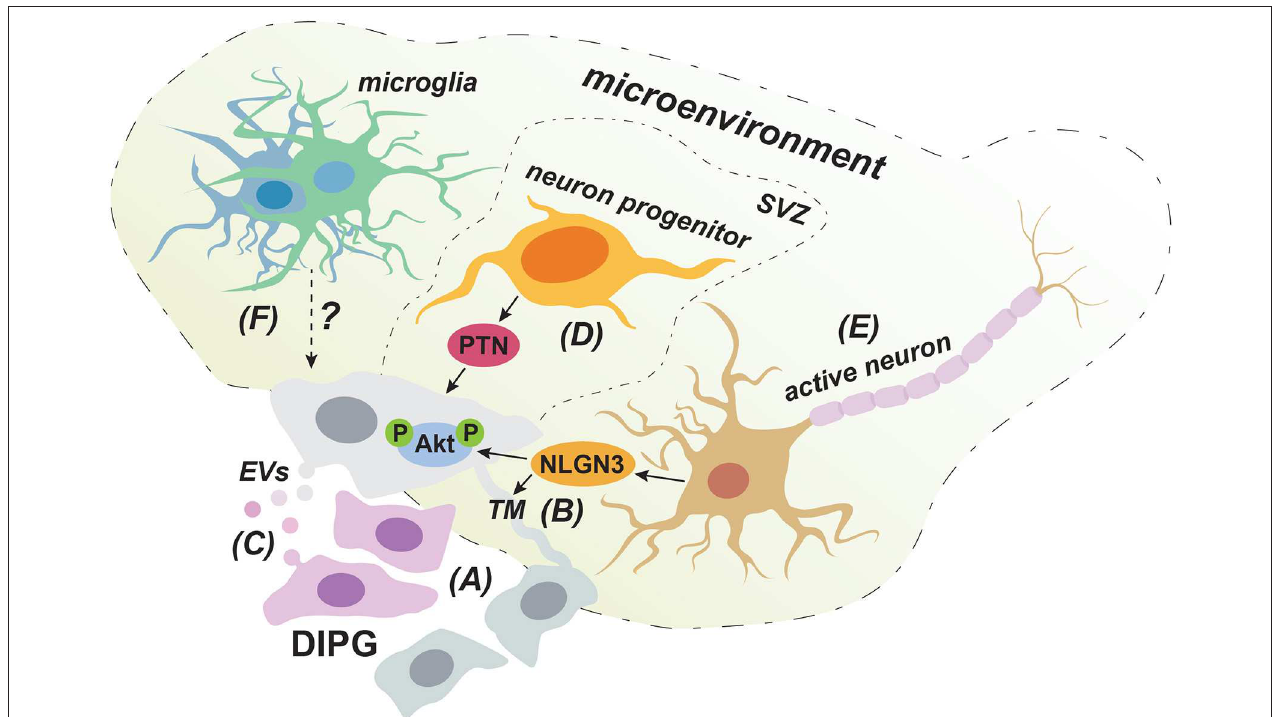
FIGURE 2 | Cell-extrinsic factors that can promote the invasive behavior of DIPG cells. DIPG tumors consist of a cooperative network of cellular subclones in which highly migratory clones can enhance the invasive behavior of less motile cells (A) . Cellular communication via both TMs (B) and EVs (C) could play a role in this clonal synergy in invasive behavior. Neuron progenitor cells promote DIPG invasion into the SVZ through the production of PTN (D) . Secretion of NLGN3 by activated neurons could contribute to DIPG invasion by inducing the formation of TMs and by activating the PI3K/Akt pathway (E) . The immune cell infiltrate in DIPG mainly consist of microglia/macrophages with a low inflammatory phenotype and it is still unclear how this impacts invasion (F)